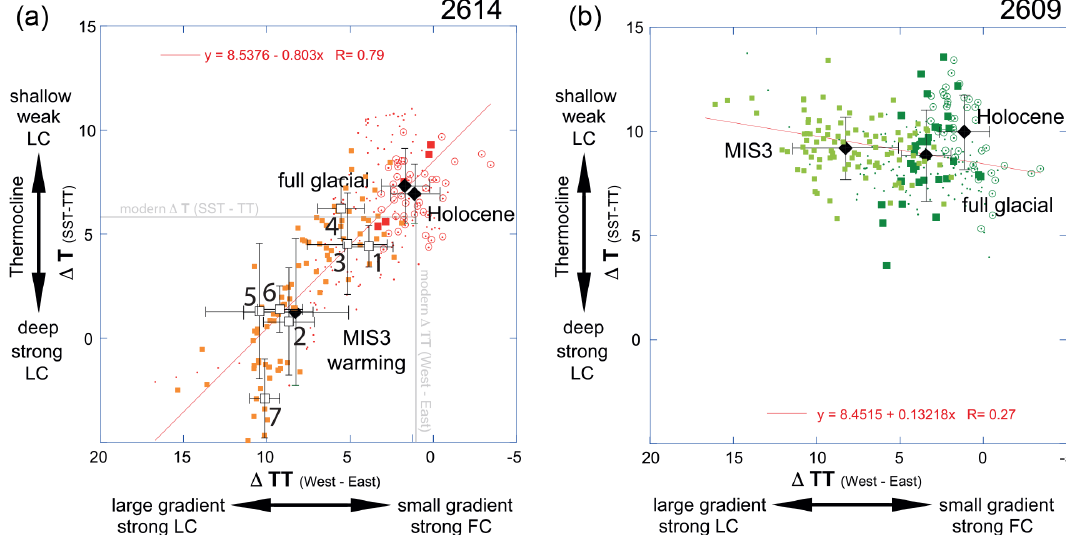
Figure 7. Vertical temperature versus lateral thermocline temperature gradient as expression of Leeuwin Current System variability. The vertical temperature gradient ( (cid:49)T SST-TT ; in ◦ C) provides insight into the thermocline depth, with low (high) (cid:49)T SST-TT pointing to a deep (shallow) thermocline. The lateral gradient at thermocline depth ( (cid:49) TT west-east ; in ◦ C) defines how the Leeuwin Current developed in relation to the Flinders Current. (a) Western core 2614 showing a well-defined relationship between (cid:49)T SST-TT and (cid:49) TT west-east ( R = 0 . 8). Promi- nent MIS3 thermocline warming periods (orange symbols; white squares are averages, numbered from 7 to 1) point to a strong Leeuwin Current, which weakened across MIS3 (black diamonds show averages) approaching LGM (red squares) and Holocene conditions (red cir- cles; black diamonds show averages). (b) Eastern core 2609 lacks a relationship between (cid:49)T SST-TT and (cid:49) TT west-east , implying that the Leeuwin Current is not affecting this study site over